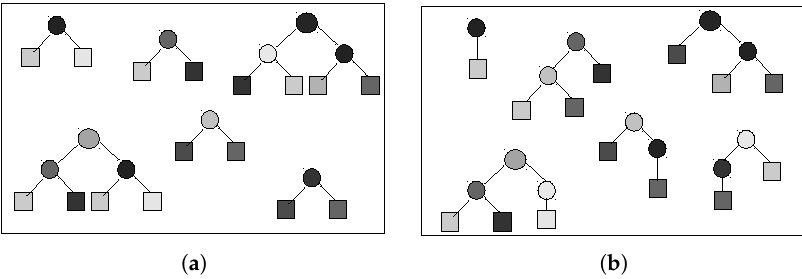
Figure 6. Methods to grow a population using GPLab. ( a ) Full: all possible nodes at each level. ( b ) Grow: random number of nodes at each level. The ramped half-and-half method means that half the population follows the full method and the other half the grow